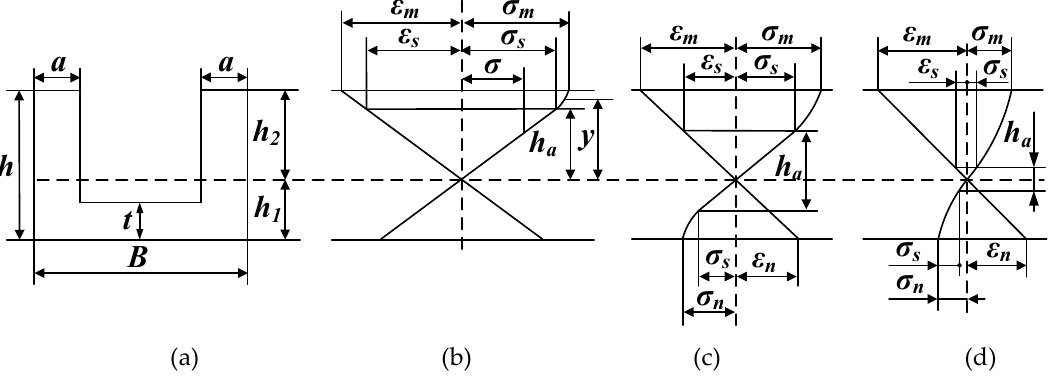
Figure 8. The U-section beam size and the stress–strain relationship under different bending degrees. ( a ) Geometry of the section ; ( b ) first stage ; ( c ) second stage ; ( d ) third stage .